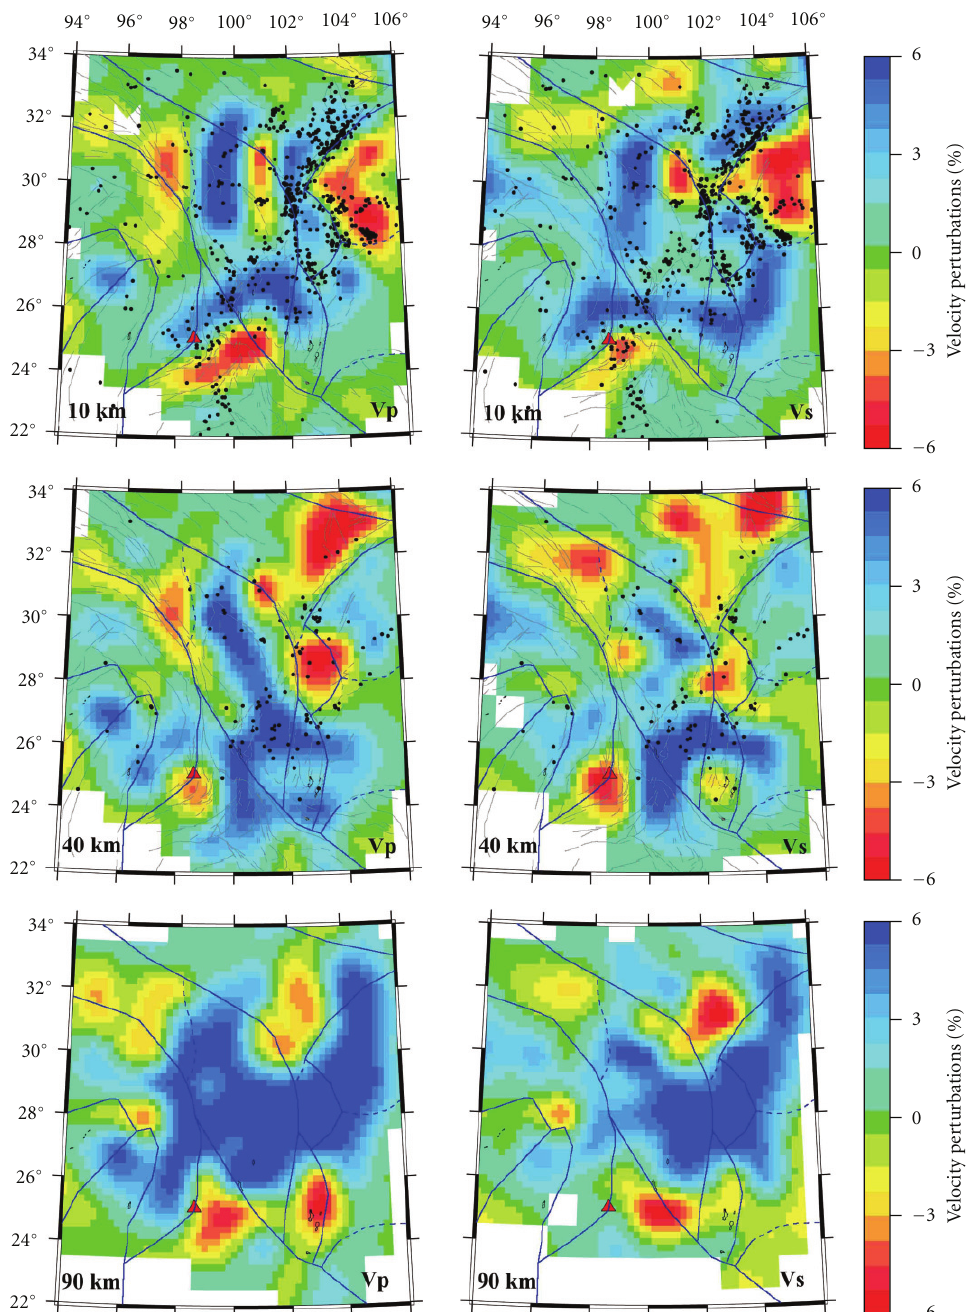
Figure 5: Plan views of P-wave and S-wave velocity images (in %) at the depths of 10km, 40km, and 90 km. The layer depth is shown in the lower-left corner of each map. Red color denotes low velocity while blue color represents high velocity. Black dots show the epicenters of earthquakes within a range of 5–10 km along each depth. Gray solid lines indicate the active faults and blue solid lines show the major plate boundaries and sutures. A red triangle denotes the active Tengchong volcano. The velocity perturbation scale and the magnitude scale of large crustal earthquakes are shown on the upper right of the